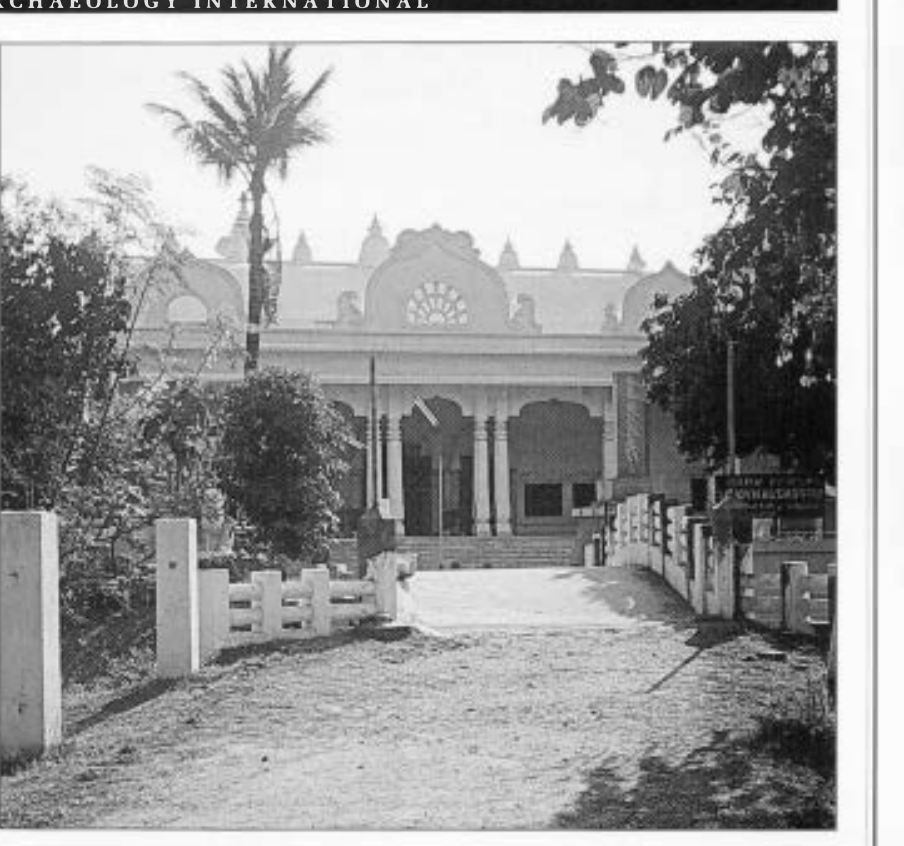
Figure 6 The new Buddhist temple on the site of Venuvana, built with the help of Japanese funding; Rajgir has again become an important focus for pilgrimage. The tem­ ple's location is based on the identification of the site by the archaeologist John Marsh all in 1905-1906. in which he described the topography of cities and their surroundings, emphasiz­ ing particular! y their historical and reli­ gious